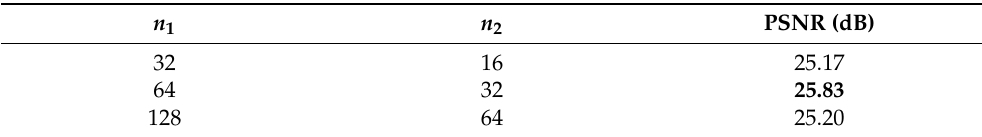
Table 1. Comparison of PSNR values of SRCNN reconstruction. Results with different numbers of convolution kernels.